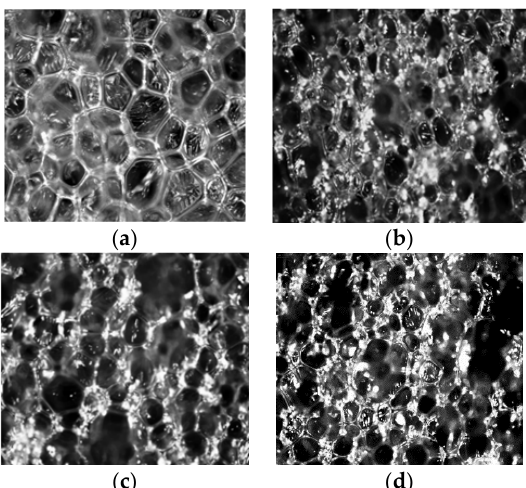
Figure 3. Images of foam using 250× magnification. ( a ) PU–0; ( b ) PU–EG; ( c ) PU–EG+SiO 2 ; ( d ) PU– EG+SiO 2